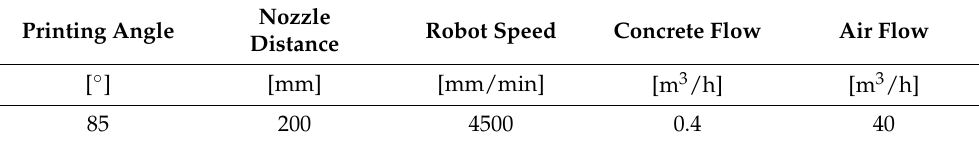
Table 3. SC3DP process parameters.